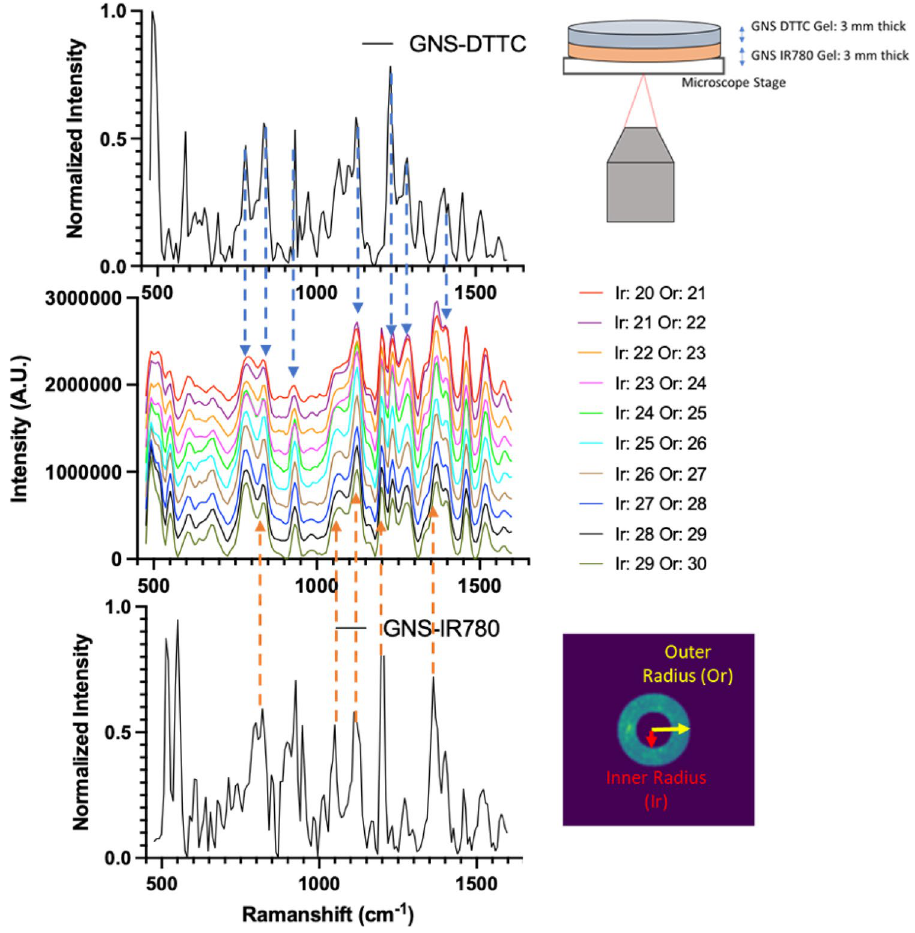
Figure 4. Detection of Raman from a dual layer sample. Two 3 mm thick gels containing GNS-DTTC and GNS-IR780 are stacked and probed with the ORCHID system at different spectral frequencies. The Raman spectra of pure GNS-dye are shown above and below a waterfall plot of different collected spectra at different radial binnings. The plot labels Ir (Inner radius) and Or (Outer radius) are the spatial offset binning. At greater spatial binning radii, spectral peaks coming from the farther layer become more prominent as shown with the changing Raman spectral peak intensities changing from each respective